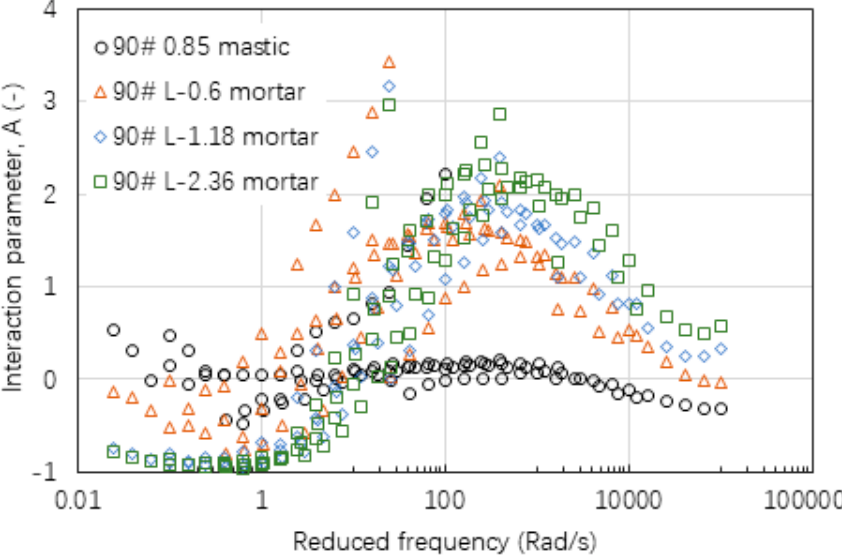
Figure 9. Interaction parameter of A values of mastic and mortar based on AC ‐ 25 mixture.